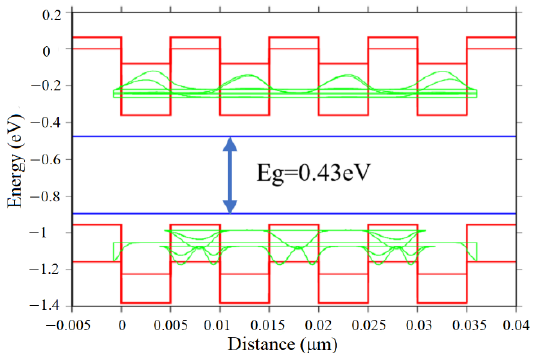
Figure 2. Energy band structure of the 5-nm-In 0.53 Ga 0.47 As/5nm-GaAs 0.51 Sb 0.49 superlattice material.